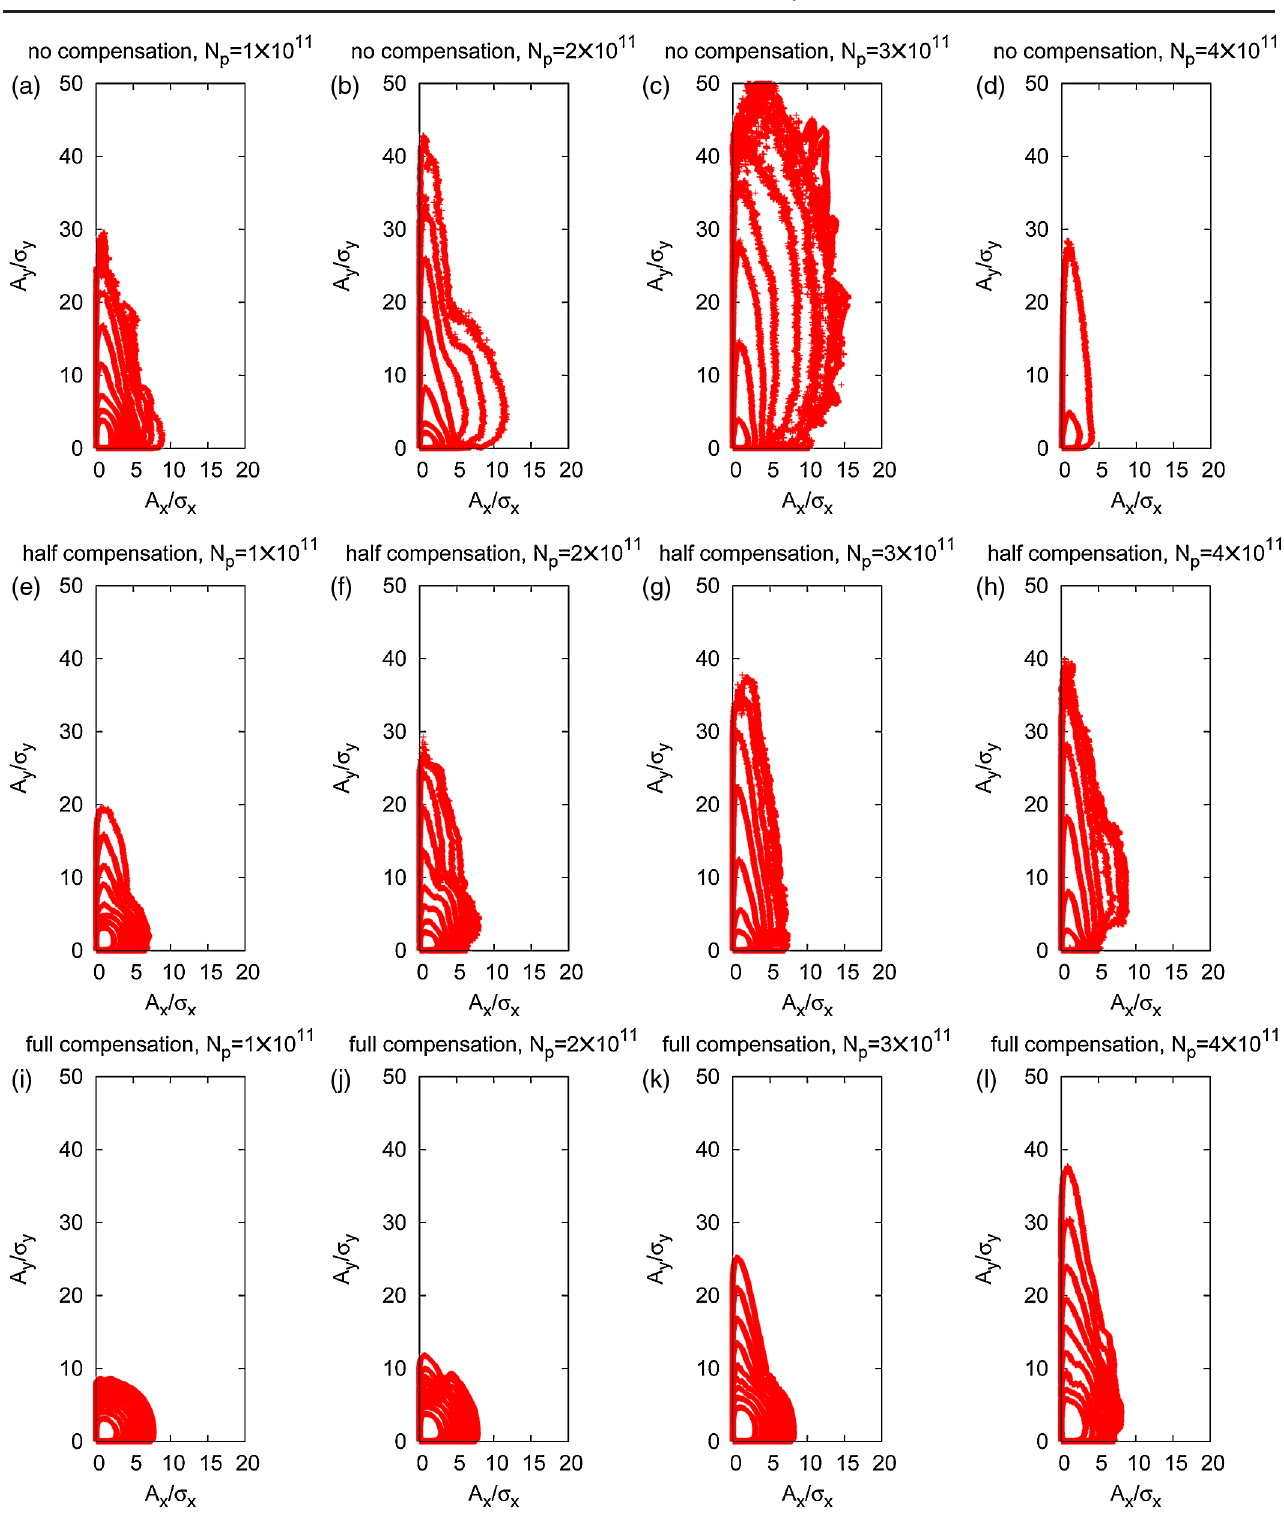
FIG. 5. (Color) Transverse electron distributions for uncompensated ( N e ¼ 0 ), half ( N e =N p ¼ 0 : 5 ), and fully ( N e =N p ¼ 1 : 0 ) compensated cases, for proton bunch intensities N p ranging from N p ¼ 1 (cid:3) 10 11 to N p ¼ 4 (cid:3) 10 11 . In the uncompensated case with N p ¼ 4 (cid:3) 10 11 , only two contour lines are shown since any further lines are outside the scale. All tail studies were performed at those tunes that, according to tune scans, resulted in the highest luminosity for each particular case. All these tunes are in the vicinity of ( 0 : 05 = 0 : 06 ). The contour lines are spaced by a factor